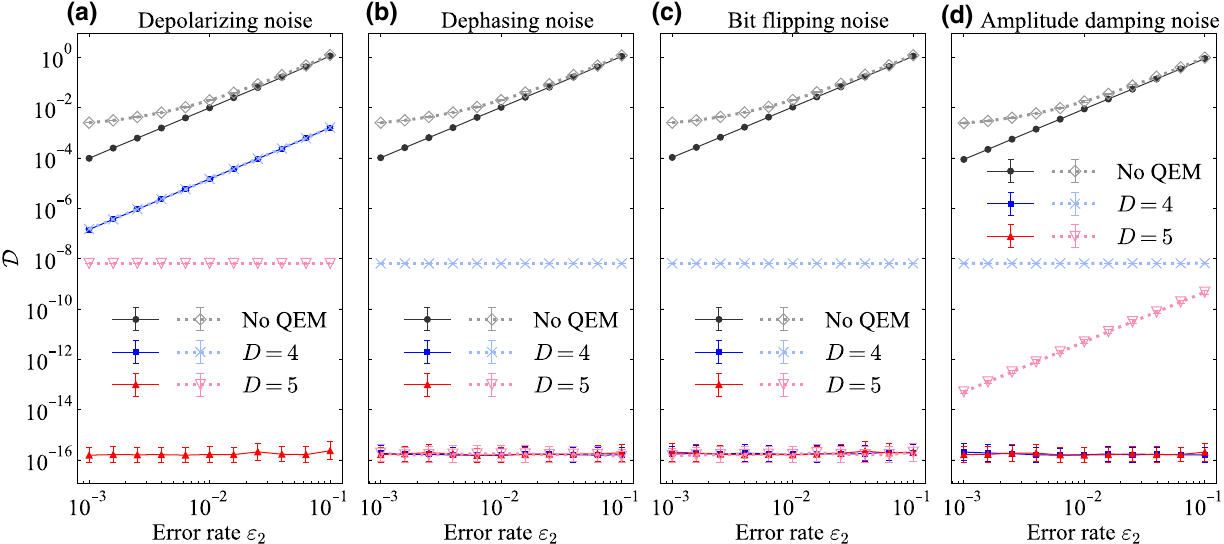
FIG. 6. Performance of our MPO-inverse method. Solid and dotted lines describe circuits without and with global N q -qubit depolar- izing noise E [ N q ] , respectively, the error rate of which is ε n = 0.01. The system size is N q = 10. We plot D ( U − 1 average error rates and benchmark D ( U , U ( 0 ) ) for the total noise effect in the original circuit, labeled “No